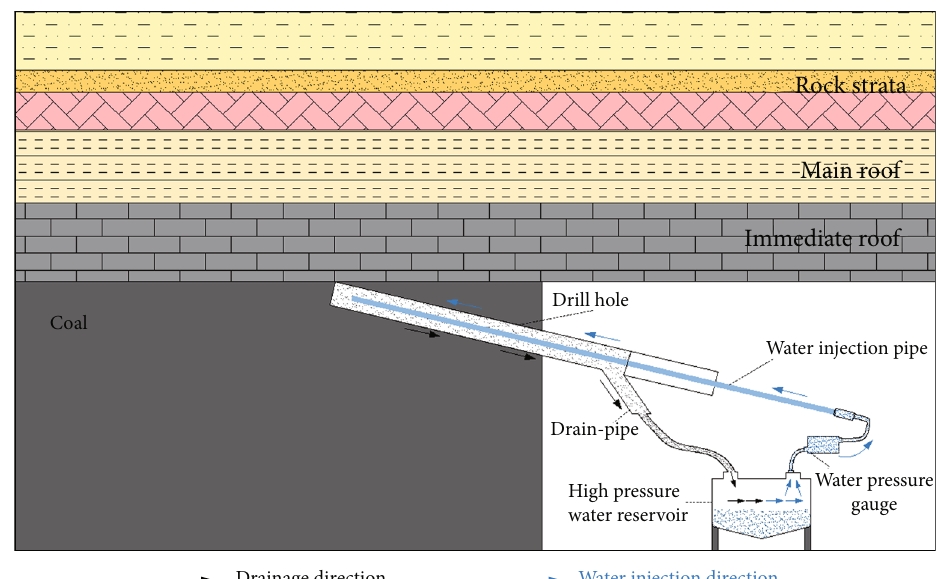
Figure 1: Schematic drawing of hydraulic perforation.